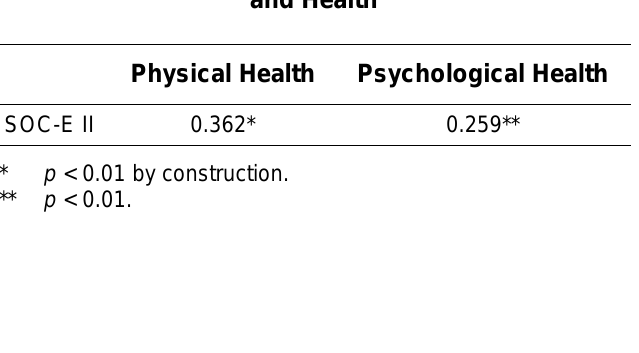
Pearson Correlation Coefficients Between SOC-E